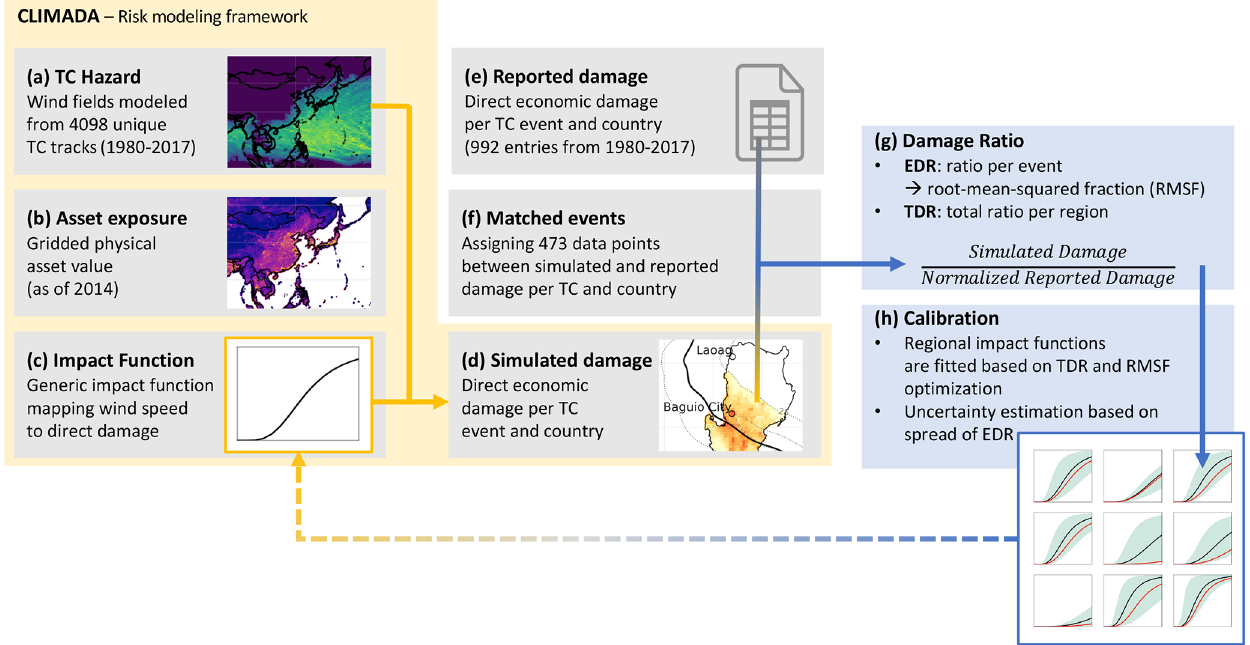
Figure 1. Schematic overview of the data and methods applied to calibrate regional tropical cyclone (TC) impact functions in a globally consistent manner. From left to right, TC event damages are first simulated within the CLIMADA framework based on TC hazard (a) , asset exposure (b) , and a default impact function (c) (cf. Sect. 2.1 to 2.2.3). Resulting simulated damages (d) are compared to reported damage data from EM-DAT (e) for 473 matched TC events (f) by means of the damage ratio (g) (cf. Sect. 2.2.4 to 2.3.2). During calibration (h) , steps (c) to (g) are repeated several times with varied impact functions for each region, optimizing the cost functions’ total damage ratio (TDR) and root-mean-squared fraction (RMSF; cf. Sect. 2.3.3). The result is a set of best-fitting impact functions for nine world regions (Sect. 3.2). Finally, the calibrated impact functions are plugged into CLIMADA once more (dashed arrow) to compute the annual average damage (AAD) per region (Sect.